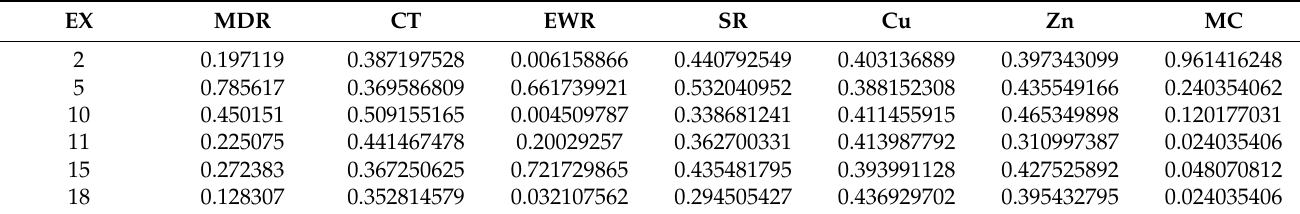
Table 8. Normalized decision matrix.